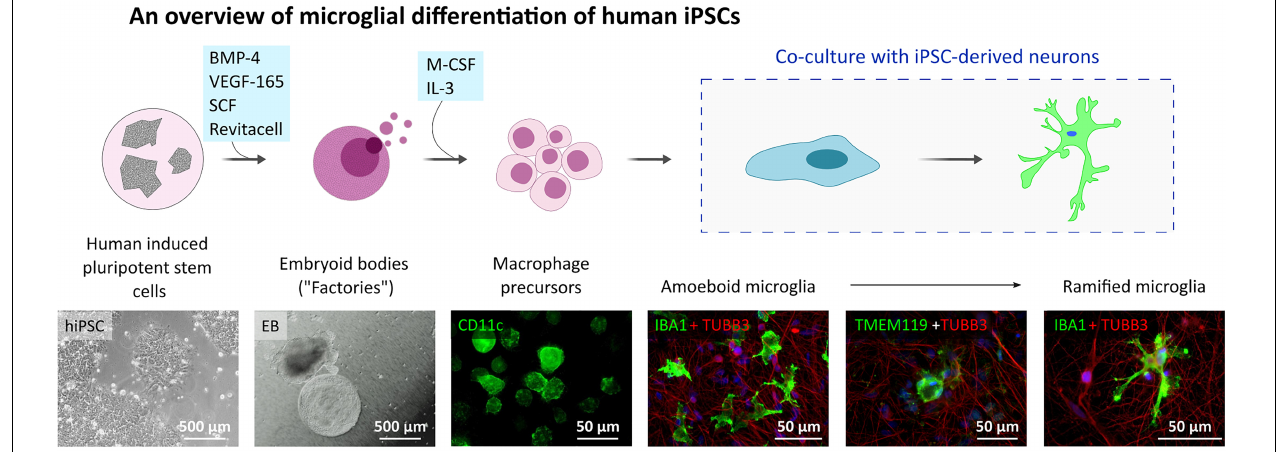
FIGURE 3 | Microglia-like cell culture characterization. Outline of the hiPSC-derived microglia-like cells differentiation and maturation in vitro . Microglia-like cells are generated from embryoid bodies (EBs) and further differentiated into macrophage precursors (first two phase contrast images). After adding the early microglia-like cells [CD11c (green) positive cells] to neuronal cultures [immunostained with TUBB3 neuronal marker (red)], they change their shape into amoeboid and later ramified and integrate into the neuronal network [IBA1 positive cells